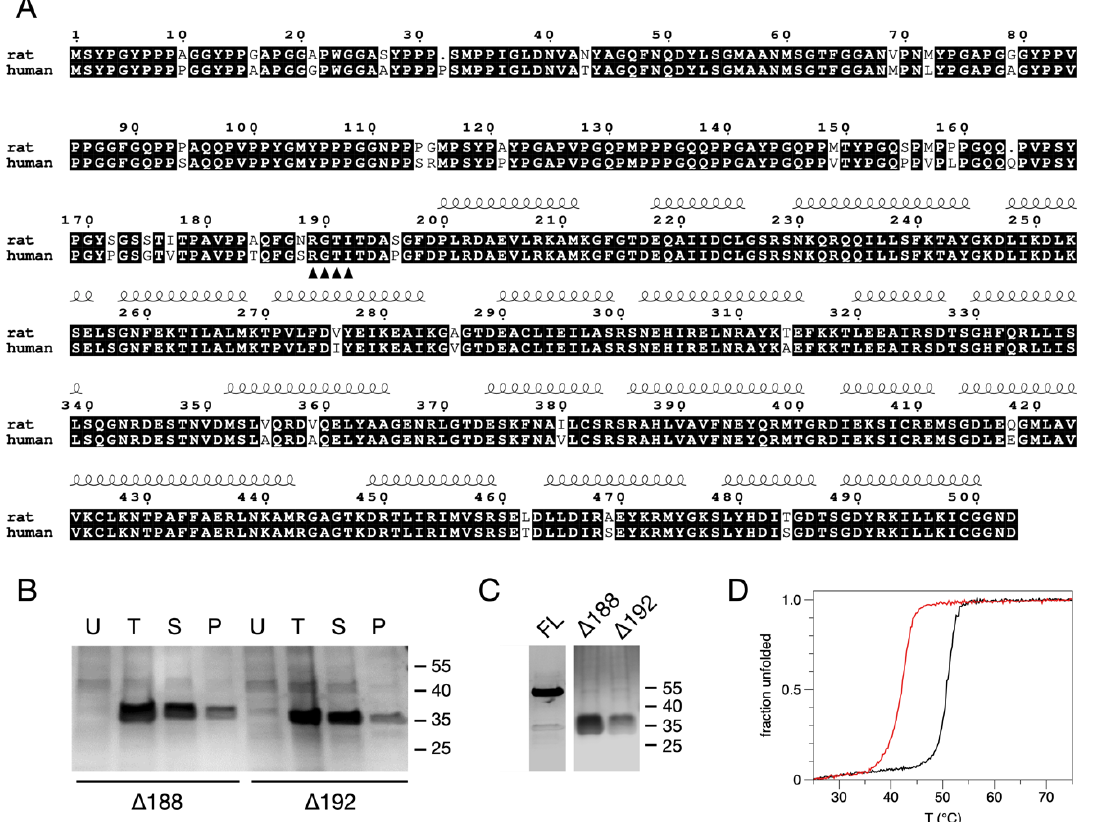
Figure 1. The solubility, purification, and stability of N-terminally truncated forms of rat AnxA11. ( A ) Sequence alignment between rat and human AnxA11. ( B ) Uninduced (U), total (T), supernatant (S), and pellet (P) fractions of bacterial lysates containing Δ 188AnxA11 or Δ 192AnxA11 as indicated. ( C ) 10 µL of FL-AnxA11 and the N-terminally truncated forms Δ 188AnxA11 and Δ 192AnxA11, purified using Co 2+ -resin. Molecular mass standards are indicated to the right. Proteins were separated in 10% SDS-PAGE gels and Coomassie-stained. ( D ) CD-monitored thermal disruption of α -helicity of 20 µM Δ 188AnxA11 (black) and Δ 192AnxA11 (red).